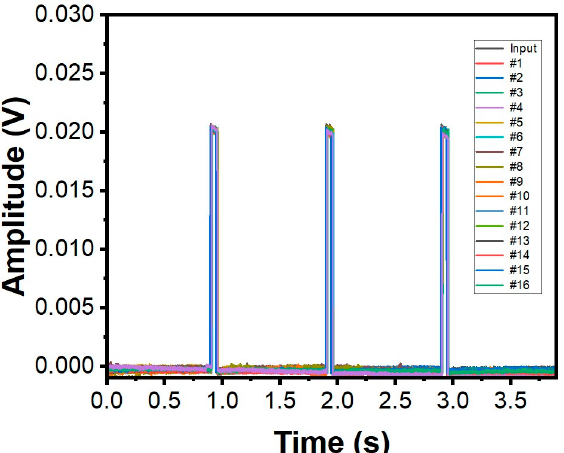
Figure 4. Input waveforms and measured waveforms using all the 16 electrodes on the SRSA in saline water. The input waveform has a voltage of 20 mV and a pulse width of 50 ms. # refers to the electrode